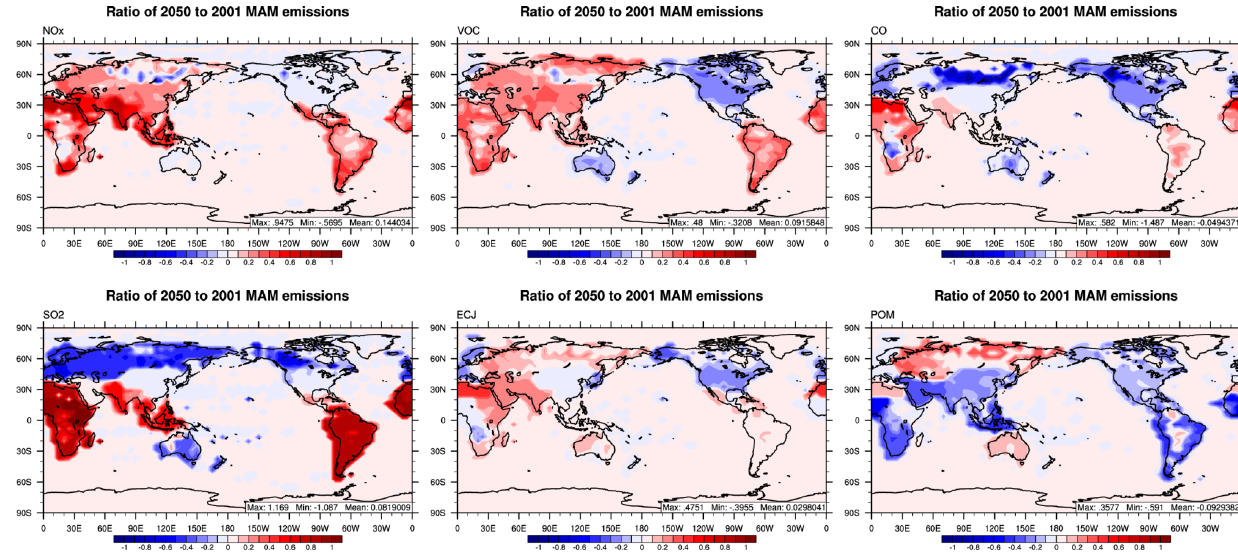
Figure 4. The logarithm of the ratio of 2050 spring (MAM) emissions to the 2001 MAM emissions of NO x , total non-methane VOC, CO, SO 2 , black carbon, and primary organic carbon.